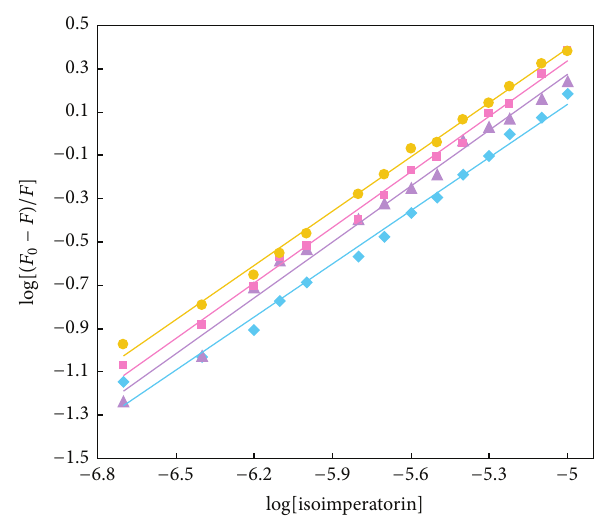
Figure 5: The modified Stern-Volmer plots for HSA fluorescence quenching by isoimperatorin at 298 ( ⧫ ), 303 ( 󳵳 ), 308 ( ◼ ), and 313 ( ∙ ) K. For interpretation of references to color in this figure legend, the reader is referred to the web version of this